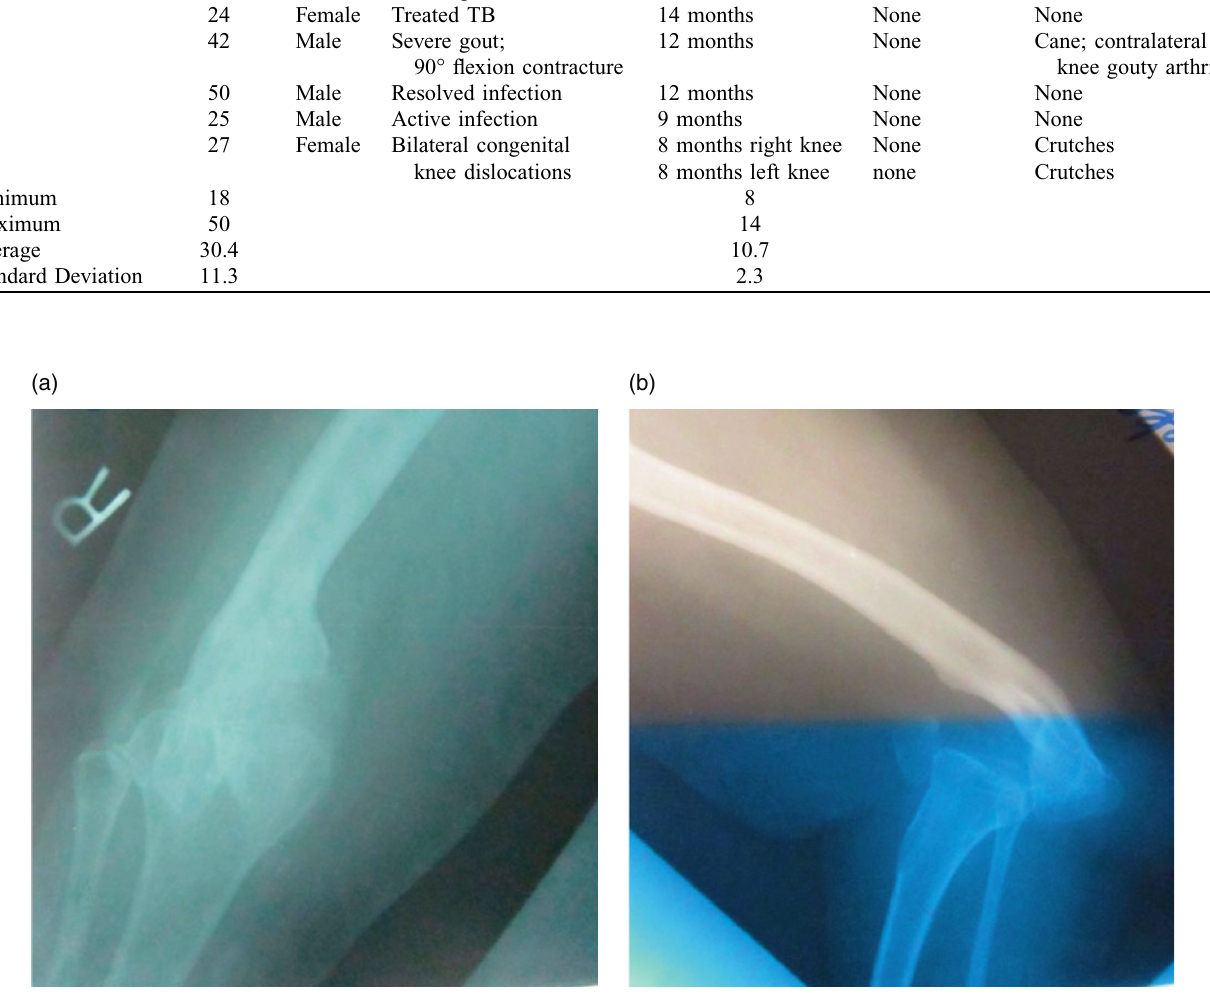
Figure 1. Preoperative anteroposterior (a) and lateral (b) radiographs of congenital knee